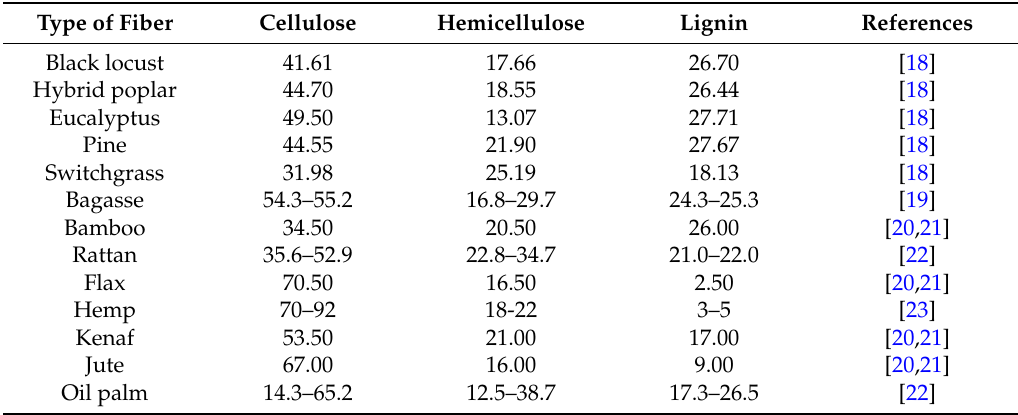
Table 1. Major chemical composition of selected natural fibers